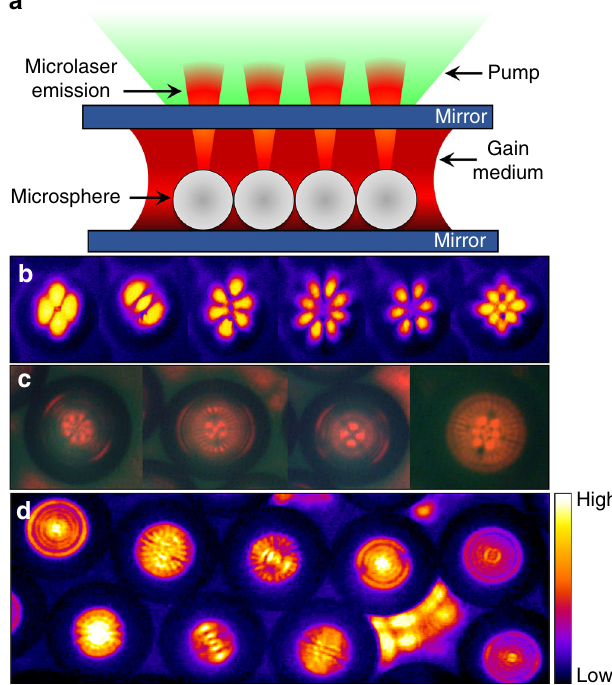
Fig. 1 Hybrid microlaser resonators. a Cross-sectional diagram (not to scale) of one con fi guration of the hybrid optical resonator. b , c Images of frequently observed IG mn modes associated with a sphere-stabilized microlaser. d Optical micrograph of a portion of an array of microspheres, illustrating (in false color) various IG transverse modes as well as lasing within several interstitial regions. For the images of b – d , all of the microspheres have a diameter of 80 μ